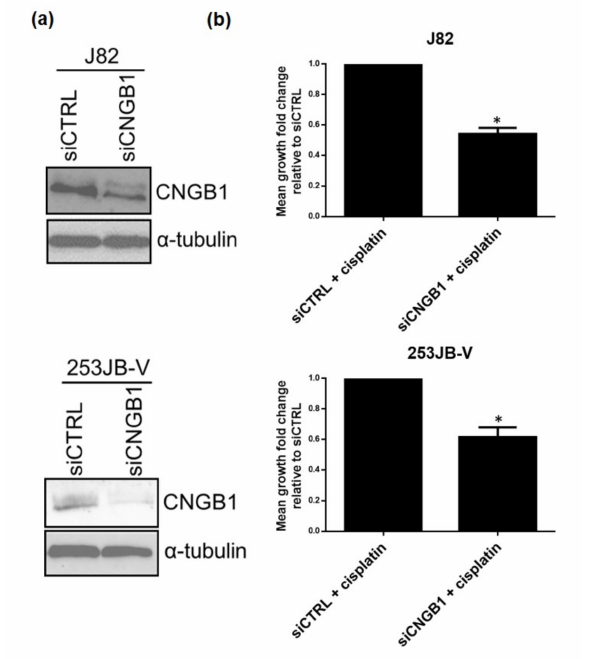
Figure 5. CNGB1 knockdown enhanced cisplatin sensitivity. ( a ) Confirmation of CNGB1 knockdown in J82 and 253JB-V MIBC cells by western blot analysis. α -tubulin was used as a loading control. ( b ) The effect of cisplatin, as a proxy for NAC, was assessed on the growth of J82 and 253JB-V cells following knockdown of CNGB1 for 48 h. Mean growth fold change relative to siCTRL was calculated for cisplatin treated cells ( n = 3 experimental repeats, t -test, * p <